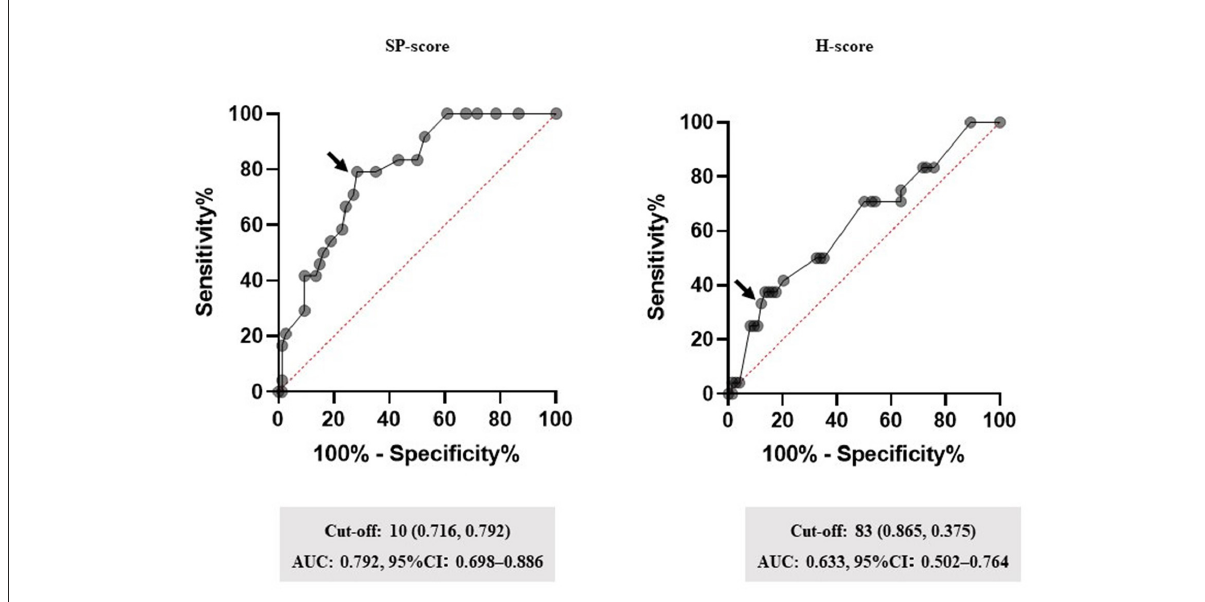
FIGURE3 Performance of the SP-score. Receiver operating characteristic (ROC) curves for the highest area under the curve (AUC) values are shown. Subsequently, ROC curves were analyzed to determine the cut-off values for each biomarker. The arrow indicates the cut-off point for each factor. Cut-off values (specificity and sensitivity), AUCs, and 95% confidence interval (CI) for each biomarker are shown. SP-score, steroid predicting score.